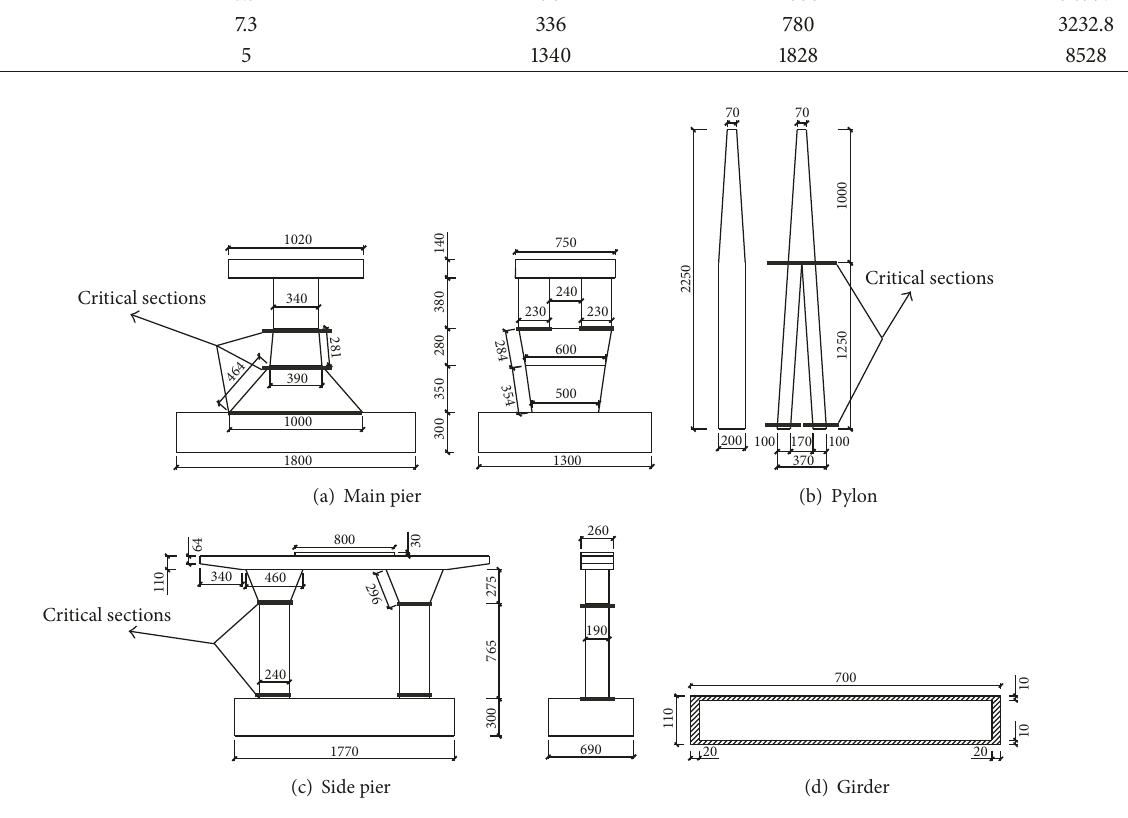
Figure 2: Detailed dimension of the scale